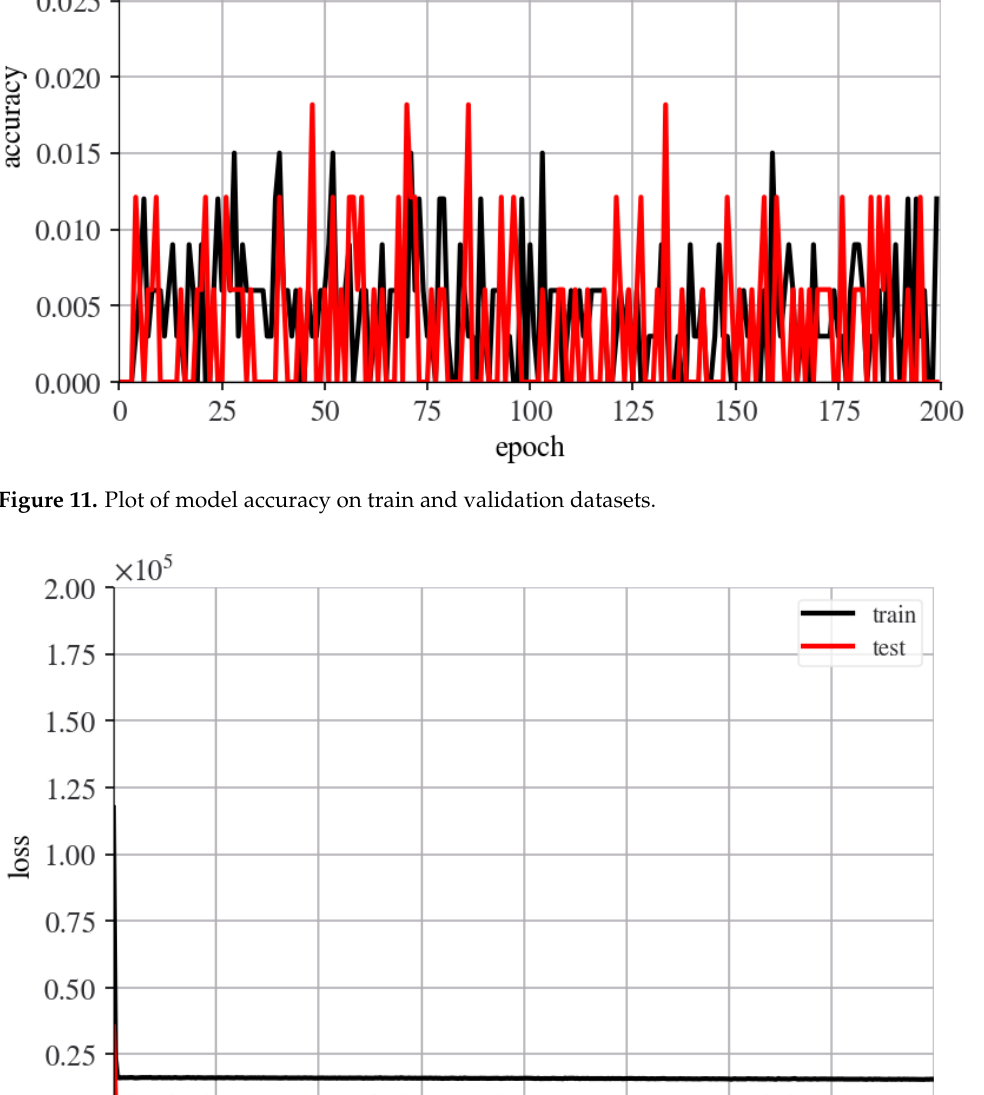
Figure 12. Plot of model loss on training and validation datasets.